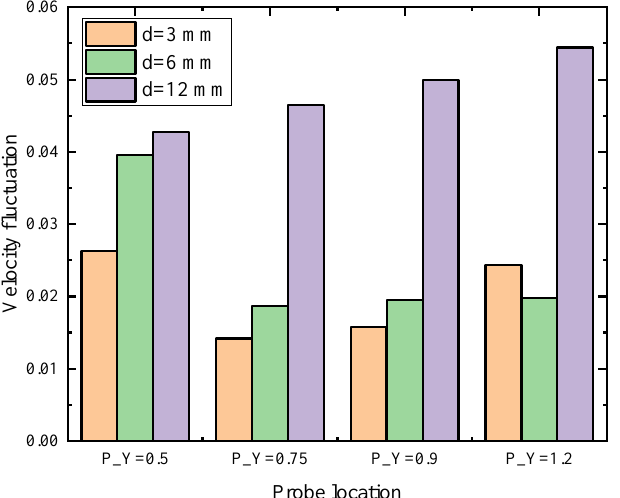
fluctuation than is found with a high-density of dispersed bubbles. Additionally, the cen-